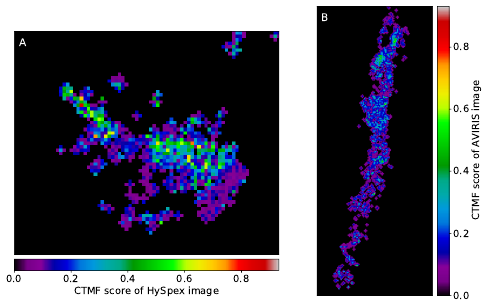
Figure 3. A : CTMF score for HySpex zoomed on the plume. B : CTMF score for AVIRIS zoomed on the plume.